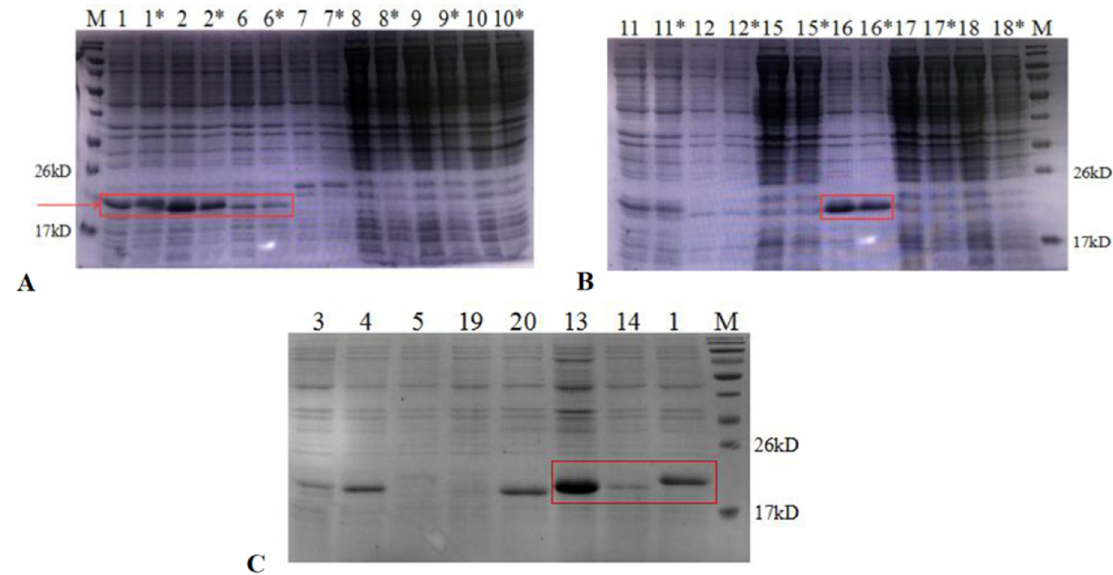
Figure 3. SDS-PAGE (12%) analysis of expression of AMPs in E. coli . ( A , B ), lane 1–18, the supernatants of EAP (1, 2, 6, 7, 8, 9, 10, 11, 12, 15, 16, 17, 18); lane 1–18*, the supernatant of EAP (1, 2, 6, 7, 8, 9, 10, 11, 12, 15, 16, 17, 18) heated to 80 °C for 30 min; ( C ), lane 1, 3, 4, 5, 13, 14, 19, 20, the supernatant of EAP (1, 3, 4, 5, 13, 14, 19, 20) heated to 80 °C for 30 min.